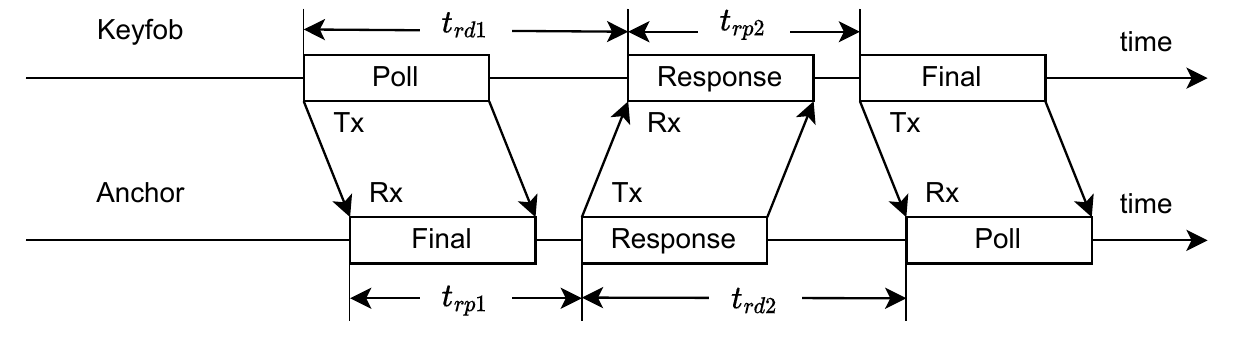
Figure 2. Illustration of the ADS-TWR ranging workflow [29].